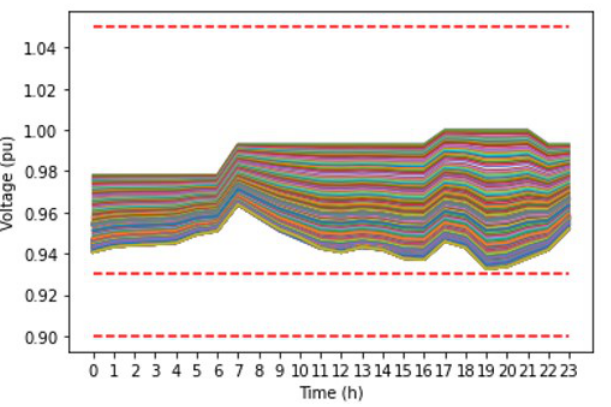
Figure 14. Voltage profile of all buses of the feeder after the hierarchical control for the mg